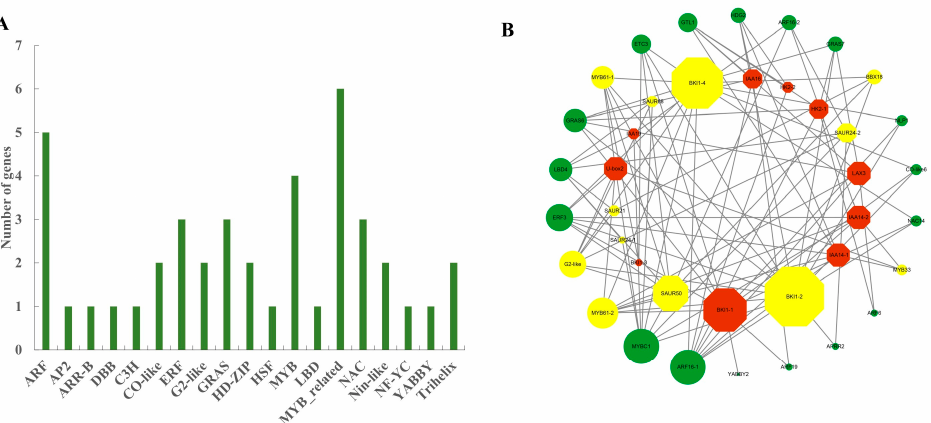
Figure 6. Analysis of differentially expressed transcription factors (TFs) in target gene co-expression network modules. ( A ) Distribution of differentially expressed TFs in the purple and cyan modules. ( B ) Co-expression network between pathway genes (hormone) and TFs. The green circular nodes represent TFs. The red octagonal nodes represent the pathway genes of the plant hormone. Among these nodes, yellow nodes represent significant differences ( p -value < 0.05). The node size is positively correlated with the gene degree.